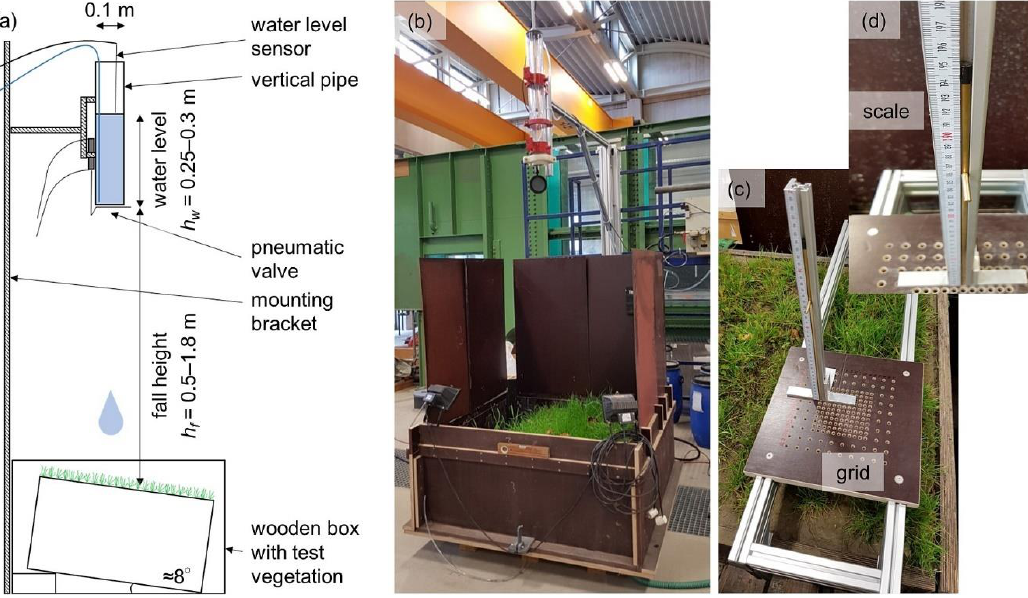
Figure 2. ( a ) Schematic sketch and ( b ) photo of the experimental test setup for simulating wave impacts by Stanczak (2008) [47]; ( c ) pin-profiler for documentation of the erosion depth, and ( d )